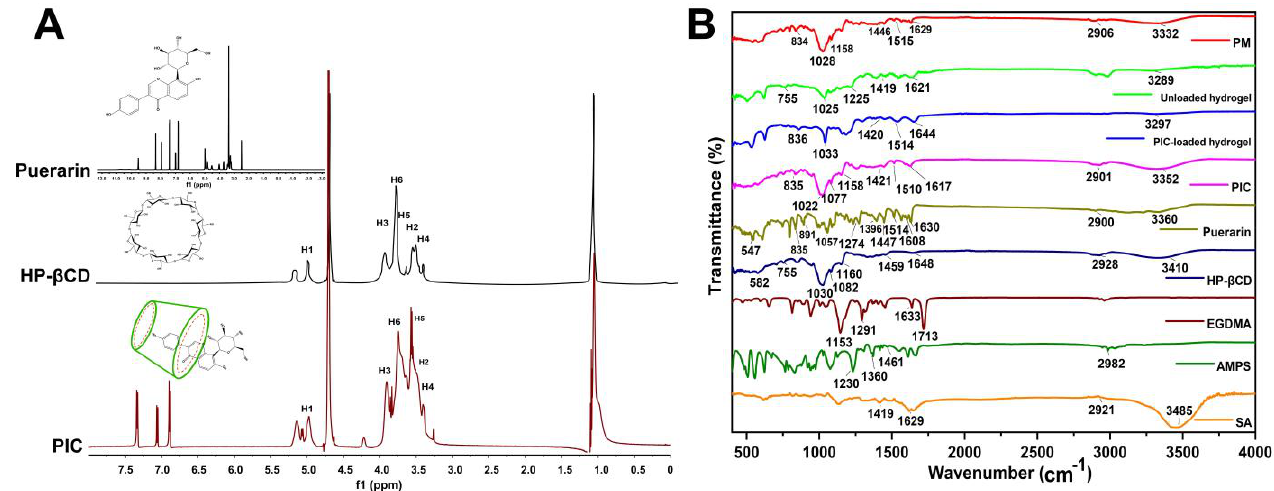
Figure 1. 1 H NMR spectra of puerarin and HP-βCD inclusion complexes ( A ), and FTIR spectra of pure components and hydrogels ( B ).